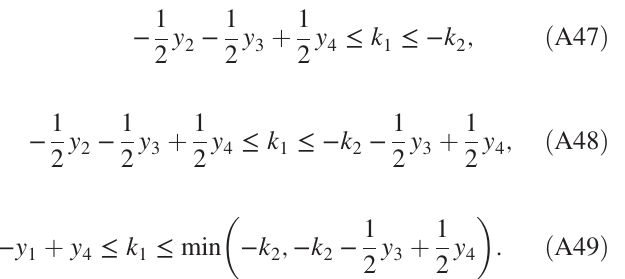
− y 0 plane; (c) the y 1 2 ¼